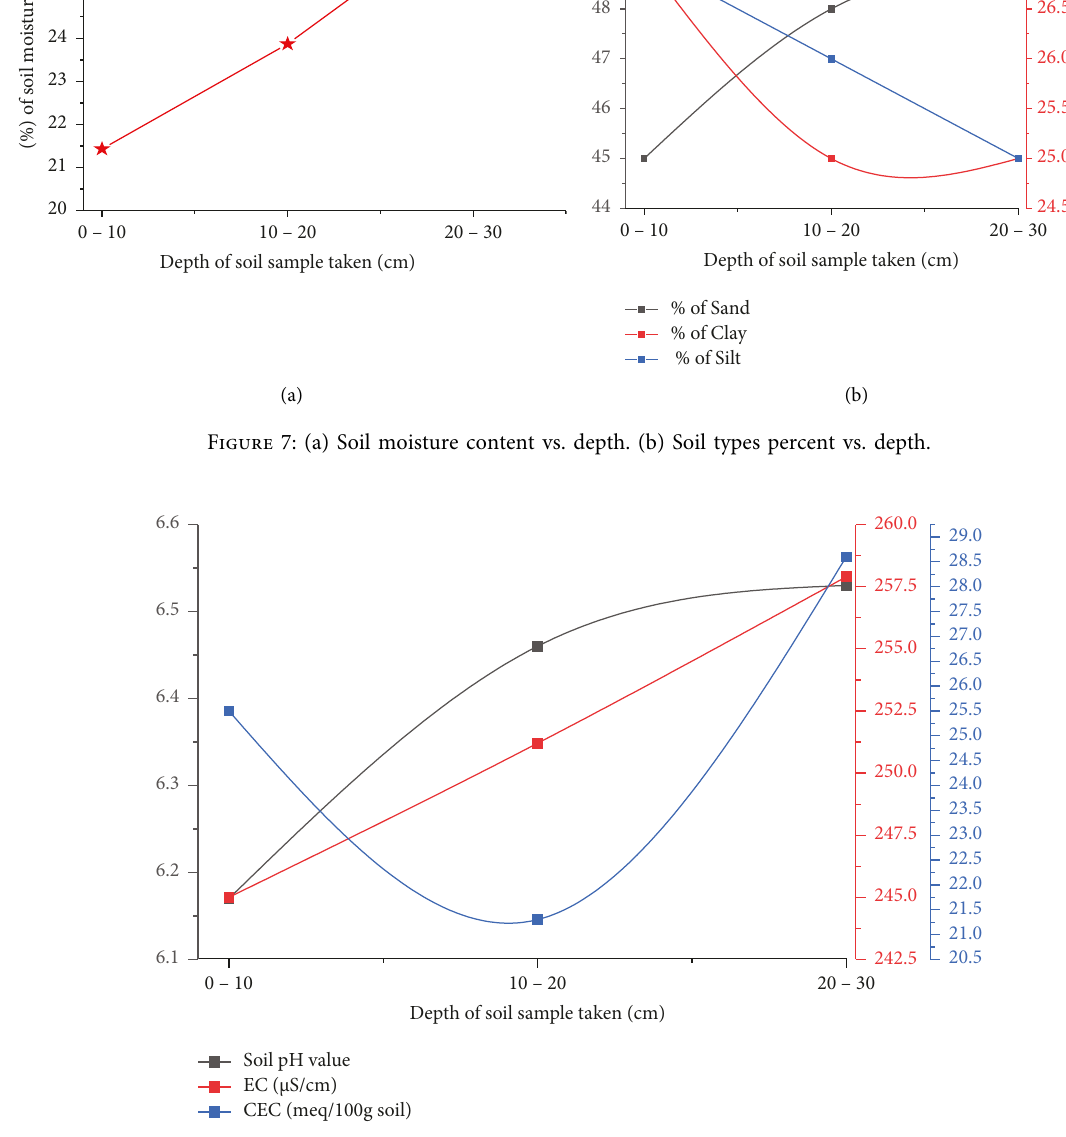
Figure 8: Soil pH value, soil EC, and soil citation exchange capacity vs. depth.